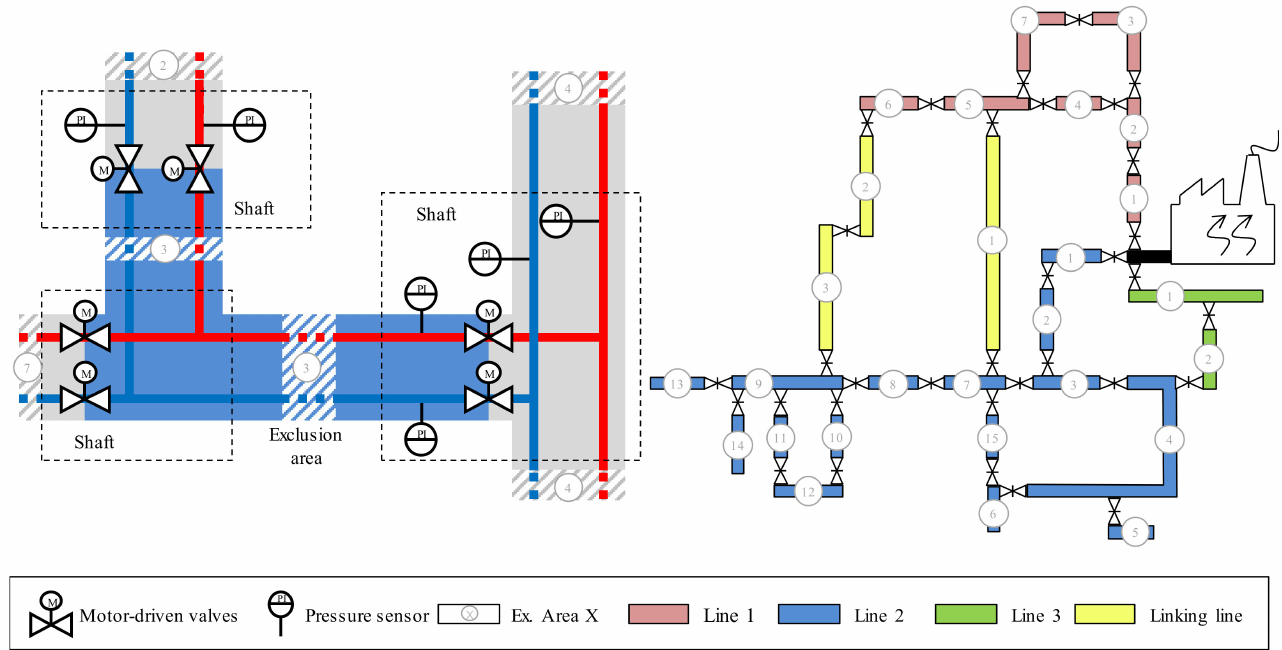
Figure 2. Exemplary exclusion area (blue 3) and simplified network topology. On the left side, the blue area belongs to EA 3. Each EA can be separated from the rest of the network by remote control. Ideally, only the EA affected by the leakage is separated [7]. The blue EA 3 is adjacent to the blue EAs 2, 4, and 7. Hence, three different shafts are visible with remote-controlled, motor-driven valves and pressure sensors. On the right side, a simplified network topology is shown, which is considered in this